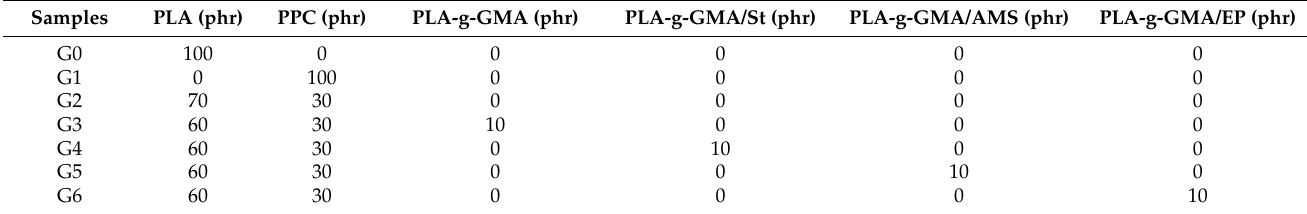
Table 3. The composition of the PLA/PPC/PLA-g-GMA blends (PLA-g-GMA contained